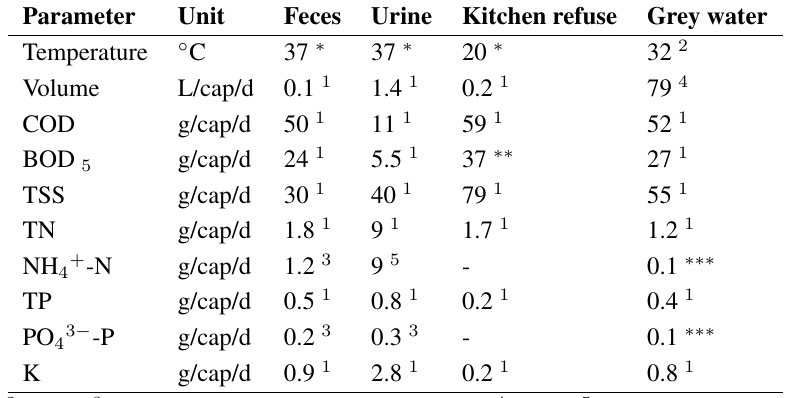
Table 2. Domestic wastewater characteristics. (COD = Chemical Oxygen Demand; BOD = Biochemical Oxygen Demand; TSS = Total Suspended Solids; TN = Total Nitrogen; 5 NH 4+ -N = Ammonium Nitrogen; TP = Total Phosphorus; PO 43 − -P = Phosphate Phosphorus; K = Potassium). Parameter Unit Feces Urine Kitchen refuse Grey water Temperature ◦ C 37 ∗ 37 ∗ 20